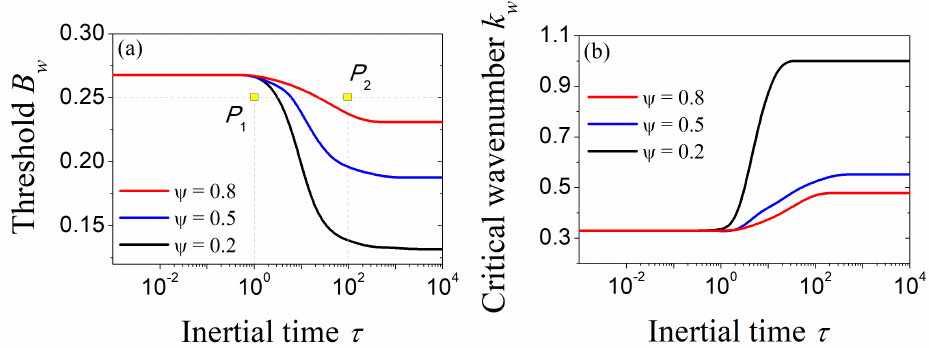
Figure 1. Inertial–time dependence of ( a ) the critical value of the control parameter at the onset of wave instability B w and ( b ) its associated wavenumber k w for different values of the seed advection speed ψ . Fixed parameter: A =